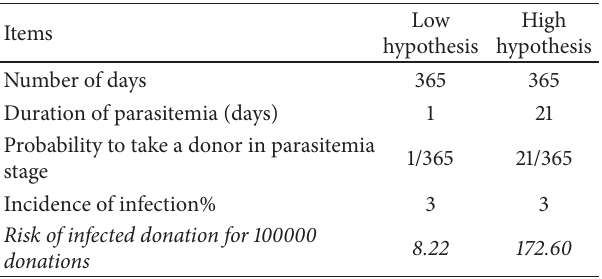
Table 5: The quantitative estimation of risk of contamination of a blood donation by Toxoplasma gondii in endemic